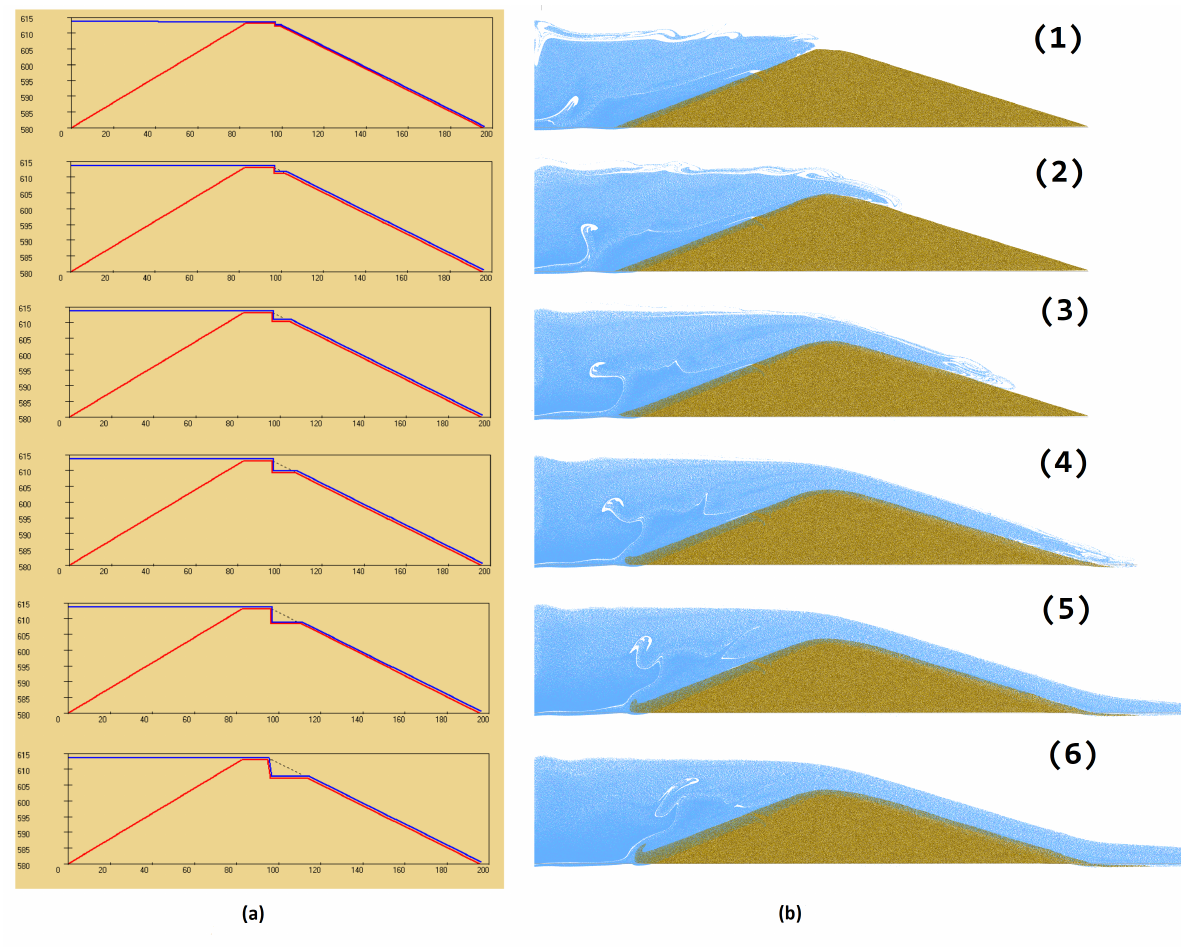
Figure 6. WinDAM C 05-HR-OBA ( a ) and the proposed MPM simulation ( b ) method